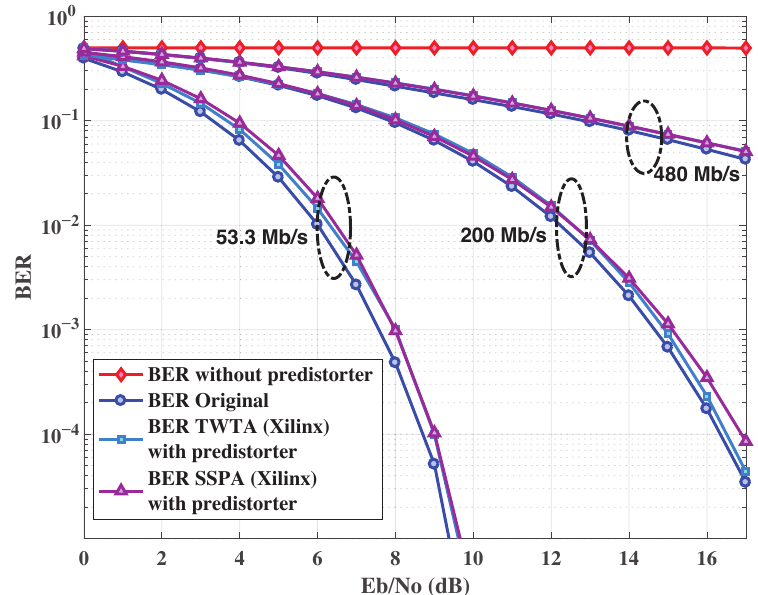
Figure 17. Bit Error Rate without and with NN predistorter for CM4.